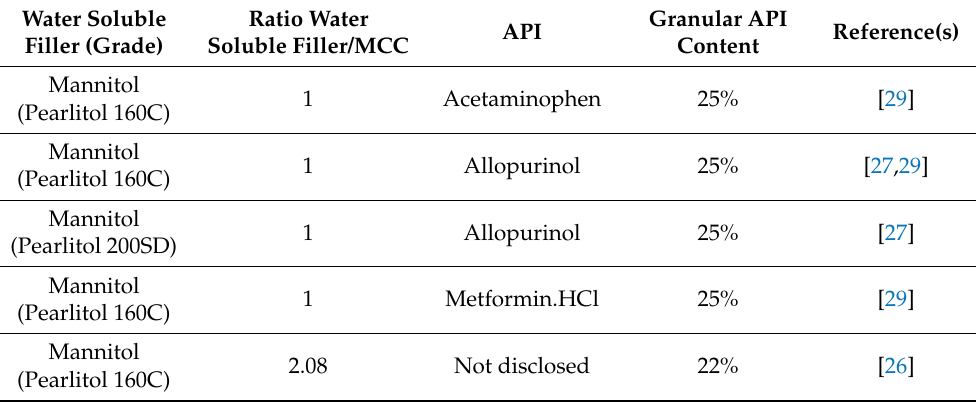
Table 2. Overview of research papers on twin screw wet granulation evaluating formulations consisting of an API and a filler combination of MCC and